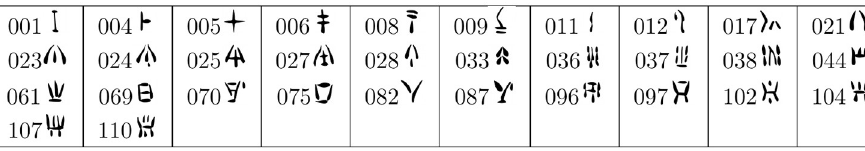
Table 3. Application of the paleographic vector to consensual graphemes using both DeepClusterv2 and Sign2Vec